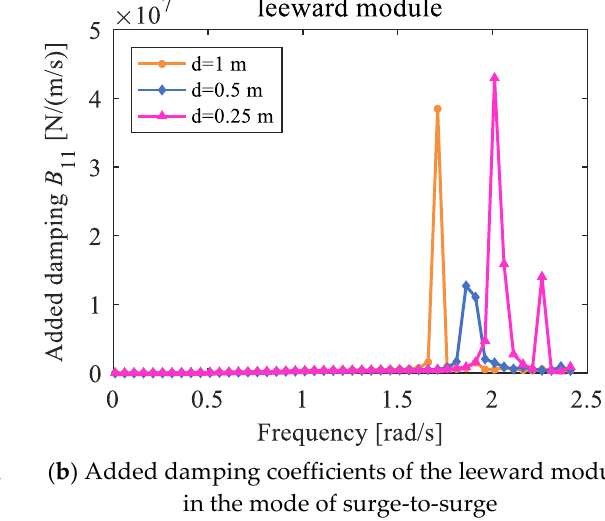
14 of 31 Figure 7. Comparison between the windward module hydrodynamic coefficients of the 3-module model with different gap widths. Although there will be a large error in the calculation of the resonance peak of the hydrodynamic coefficients in the potential theory, it has high reliability in the calculation of the resonance frequency. Table 2 summarized the resonance frequency calculated by Equation (5). As shown in the table, the resonant frequency of multi-floating systems with gap spacing of 1 m, 0.5 m, and 0.25 m are 1.79 rad/s, 1.97 rad/s, and 2.08 rad/s re- spectively. These results are all in fairly good agreement with the numerical calculation, the margin of error was 4.5%, 5.6%, and 3.4%, respectively. Which cross-verified the high prediction accuracy of the modified equation in predicting the resonance frequency. The resonance phenomenon only occurs within a certain frequency range, and the resonance behaviour is also constrained in a relatively narrow frequency band. Table 2. Resonance frequency calculated by Equation (5) and numerically. Gap Width(m)